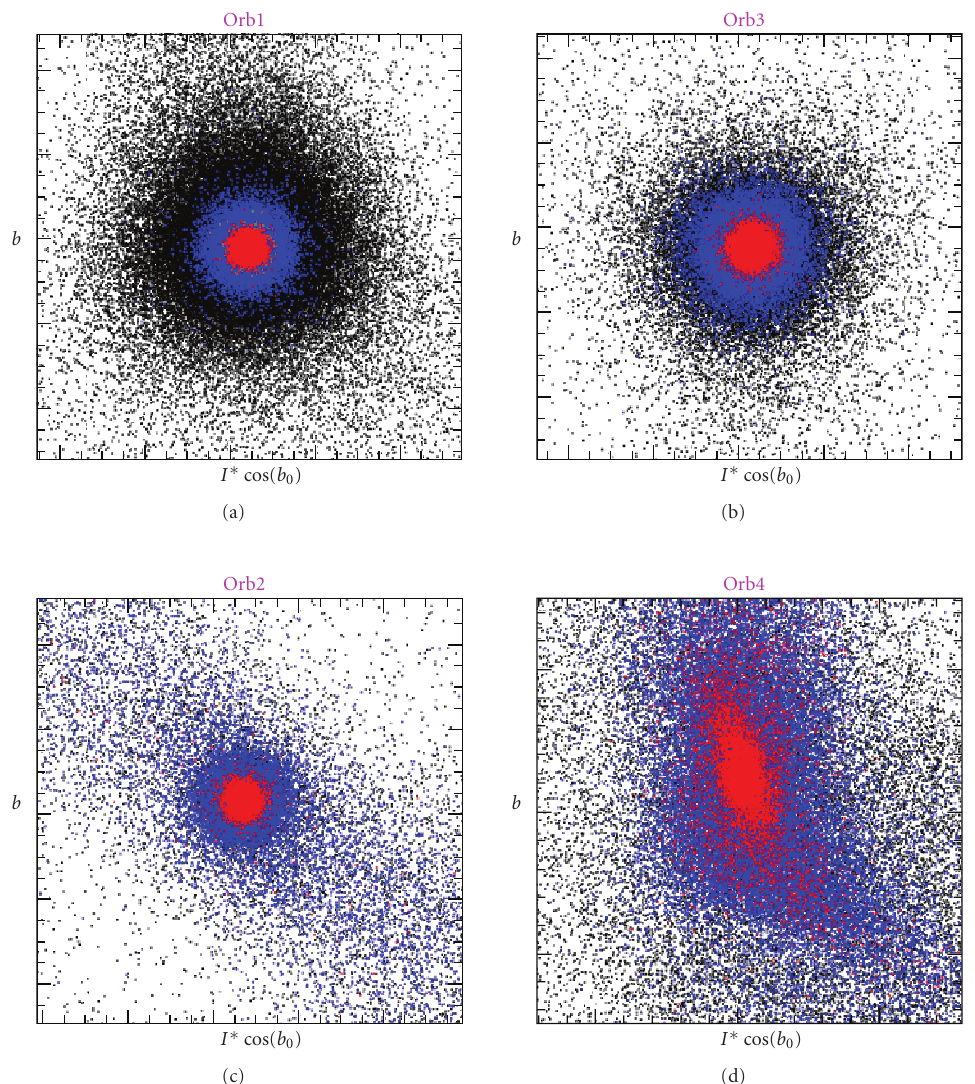
Figure 3: Final projected view (arbitrary units) of the dark matter (black), metal poor (blue) and metal rich (red) stellar components for the models evolved in orbits 1–4 during t ∼ 6Gyr. Due to the di ff erent degree of tidal disruption experienced in each case, some satellites have turned more elliptical in shape in either one (Orb2) or both (Orb4) their stellar components. Satellites in orbits 1 and 4 remain still quite spherical as the progenitor model.